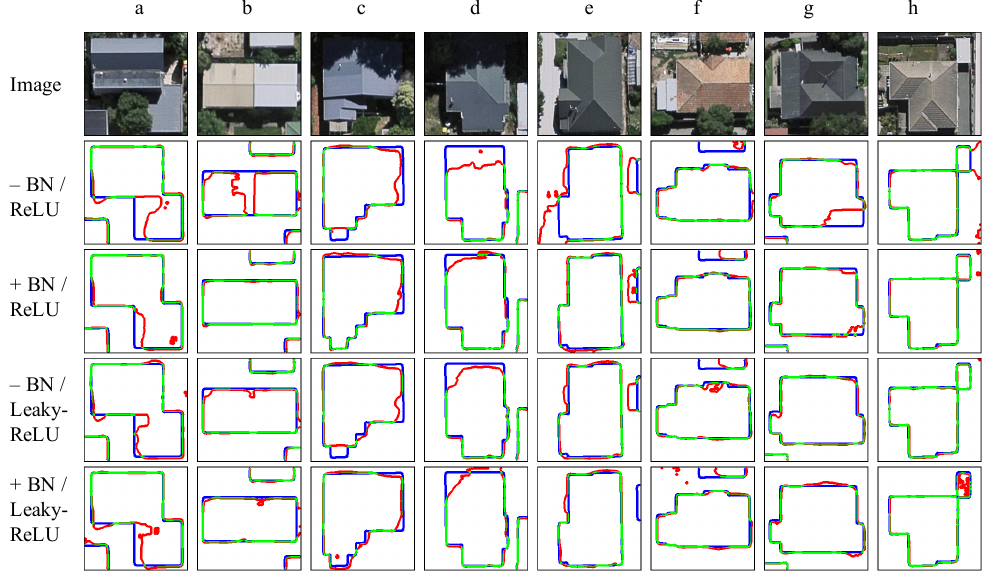
Figure 12. Representative results of single-building-level outline extraction from BR-Net with various combinations of components. The green, red, blue, and white channels in the results represent true positive, false positive, false negative, and true negative predictions,